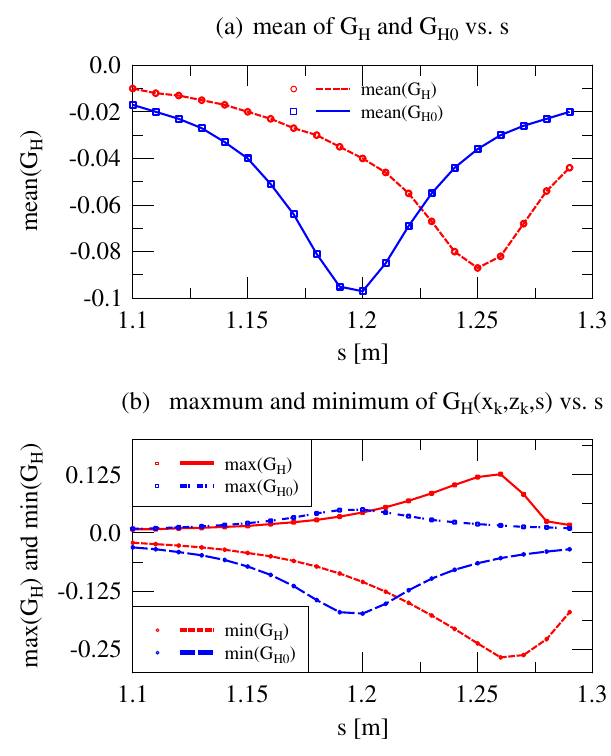
(cid:3) ~ x; ~ z; s (cid:5) vs ~ z for the representative particle of the bunch at each s for the thin-bunch case with (cid:18) FIG. 6. (Color) G H (cid:1) 10 (cid:4) 4 . The red dots are obtained from Eq. (134), and the blue line is the rigid-line bunch result in Eq. (140). The green line and (cid:12) H 0 for s (cid:1) 1 : 10 m case is the result from Eq.